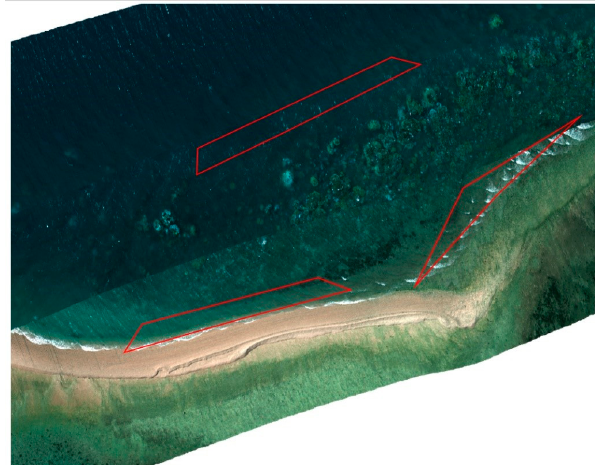
Figure 5. Multi-orthorectification by Headwall SpectralView overlaid in Google Earth, polygonal regions (in red) indicate visible spume regions in close proximity to coral.